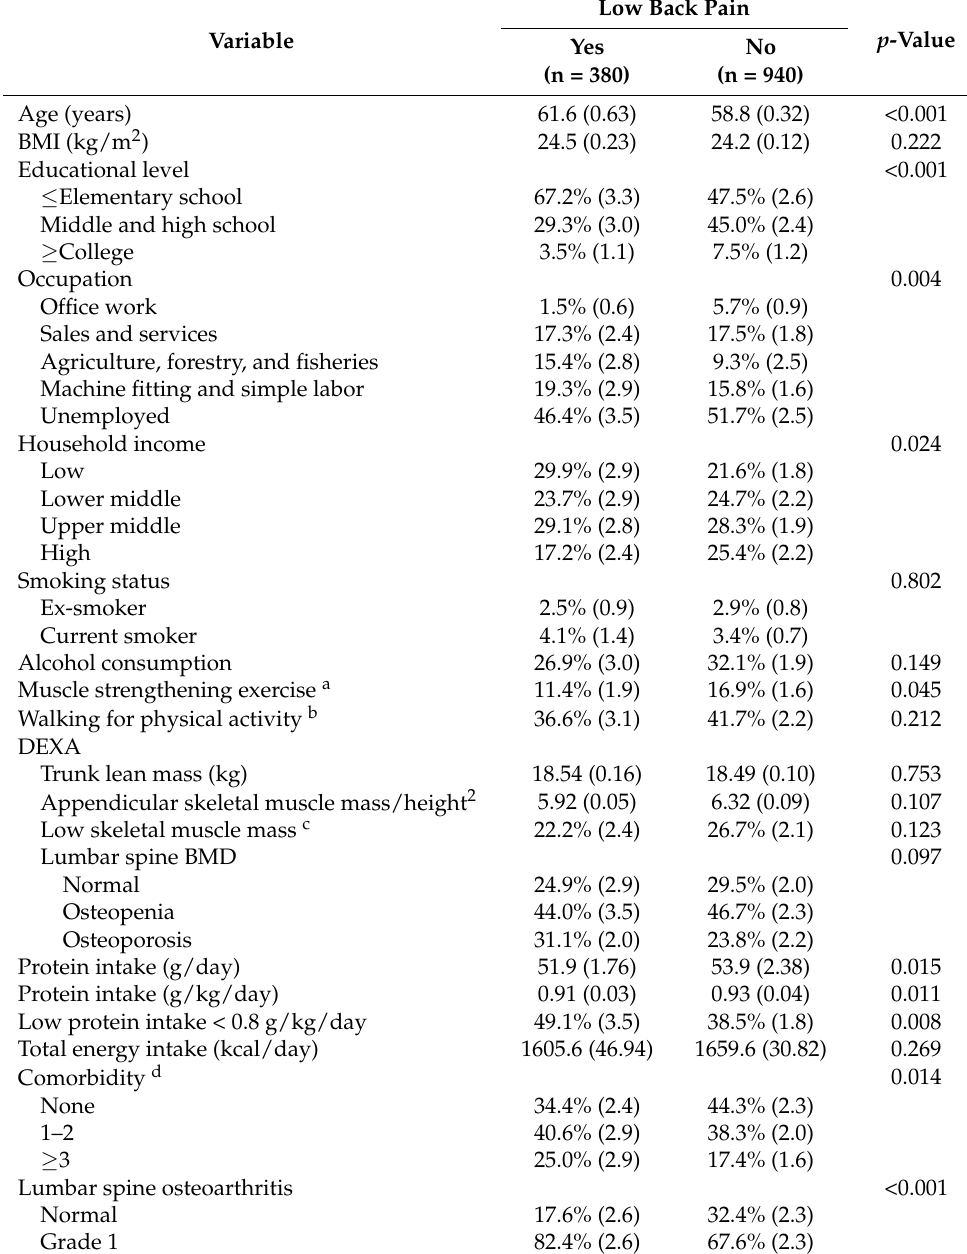
Table 3. Factors associated with low back pain in